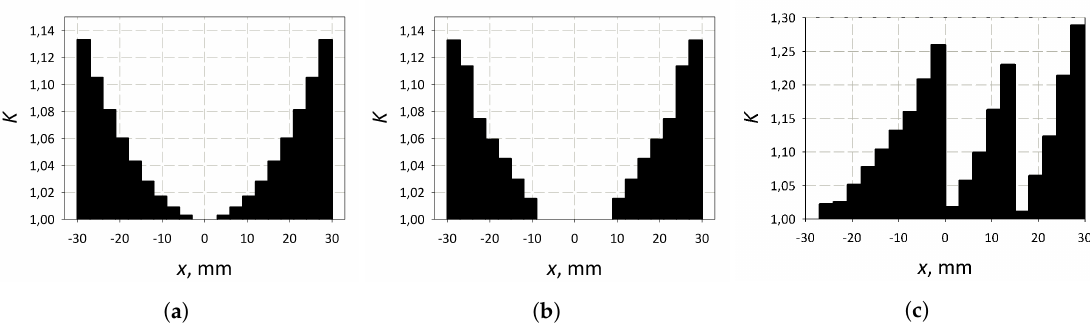
Figure 6. Spatial distributions of the K -factor of the ferroelectric lens for focusing radiation of ( a ) the isotropic source and ( b ) of the horn antenna; and for ( c ) the deflection of the focused horn